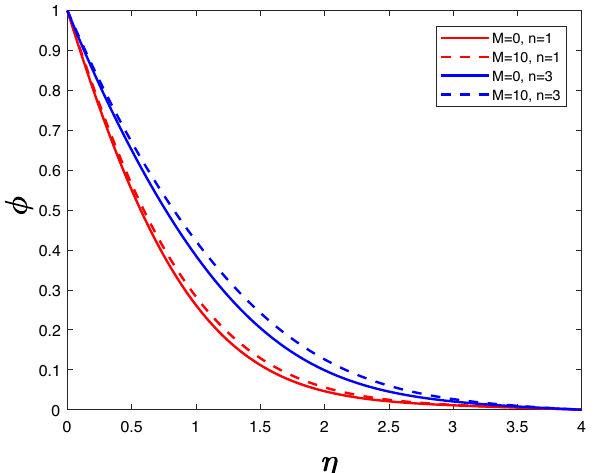
Figure 5. Concentration profile for various M .